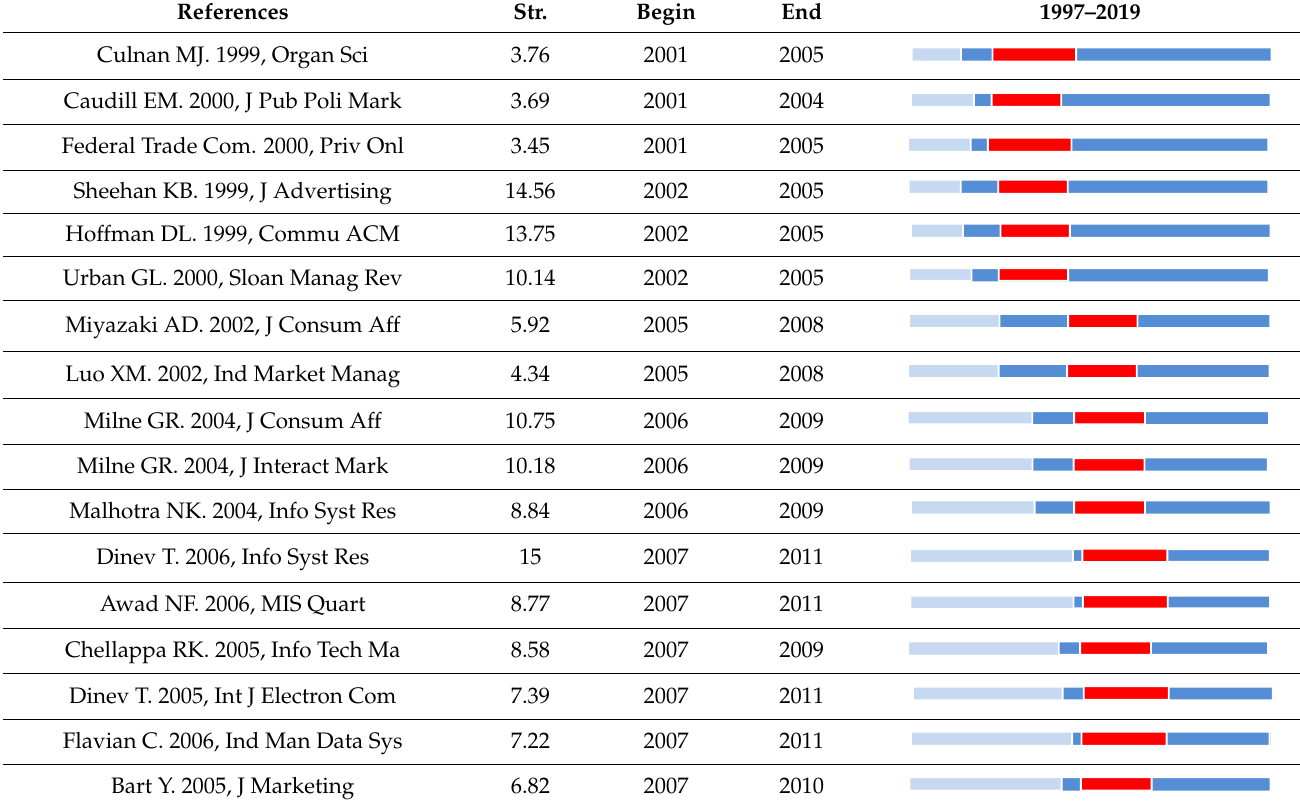
Table 5. Top 45 references with the strongest citation bursts.